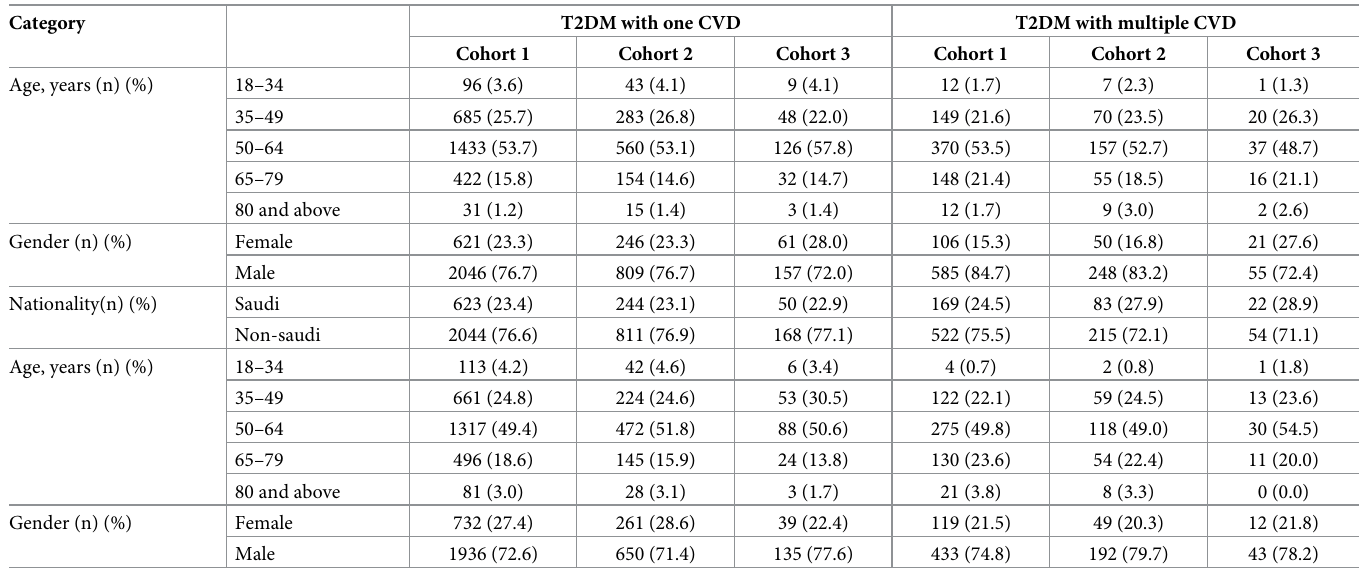
Table 2. Demographic characteristics of Payer 1 and Payer